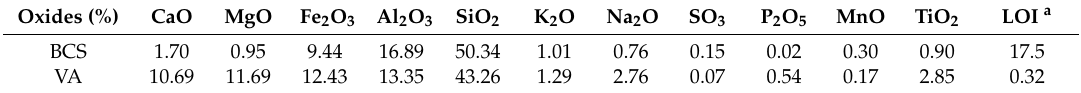
Table 2. Chemical (oxide) composition of BCS and volcanic ash